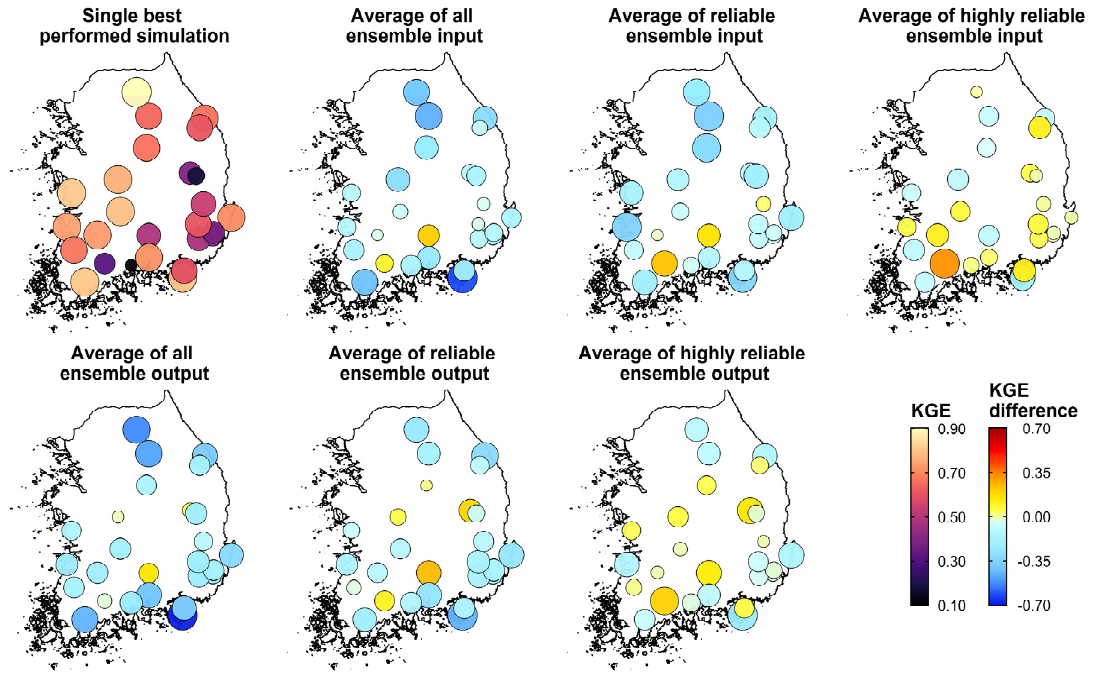
Figure 8. Spatial patterns of KGE differences between simulated streamflow from the six ensemble scenarios (described in the top of each figure) and the best-performing single simulation (top left) over the validation period.